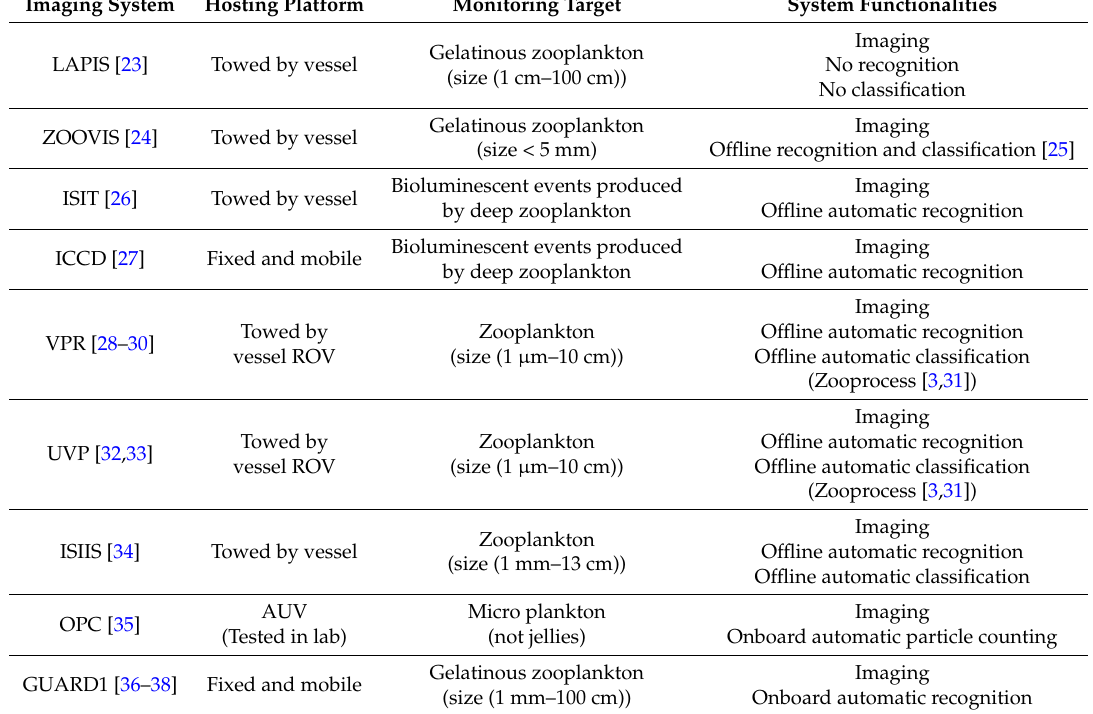
Table 1. Summary of the main imaging devices developed for automatic monitoring of zooplankton. For comparison purposes, the functionalities of the GUARD1 system, object of the present paper, are